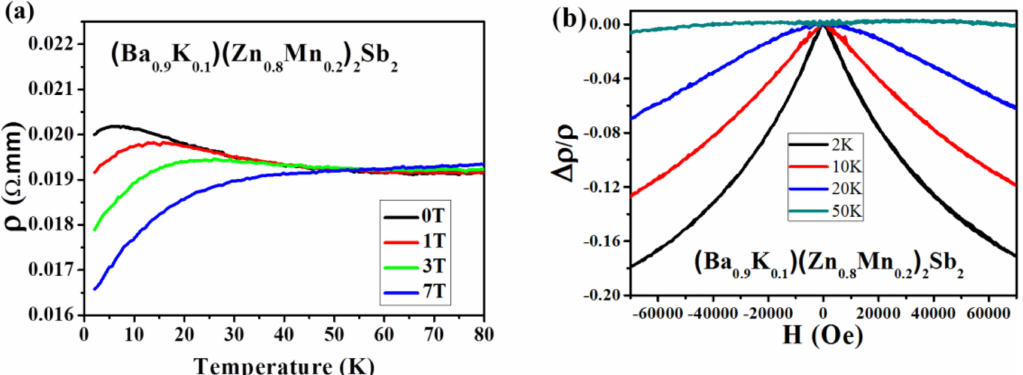
Figure 5. ( a ) ρ ( T )curves of (Ba 0.9 K 0.1 )(Zn 0.8 Mn 0.2 ) 2 Sb 2 under various fields; ( b ) the magnetoresistance curves of (Ba 0.9 K 0.1 )(Zn 0.8 Mn 0.2 ) 2 Sb 2 measured in an external field up to 7 T at T = 2 K,10 K, 20 K, 50 K, respectively.